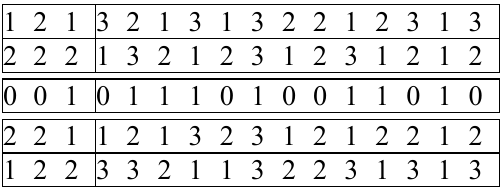
Fig. 2. Crossover operator